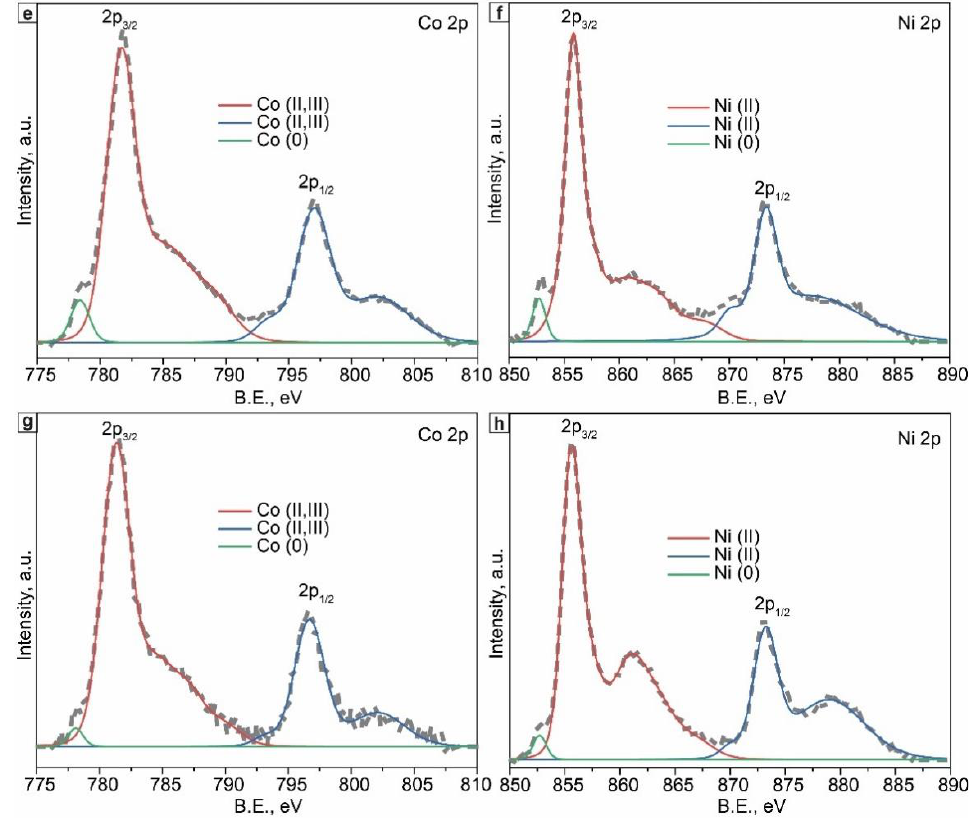
Figure 3. High-resolution XPS spectra of the as-synthesized ( a ) Co, ( b ) Ni, ( c , d ) Co 3 Ni, ( e , f ) CoNi, and ( g , h ) CoNi 3 catalysts.